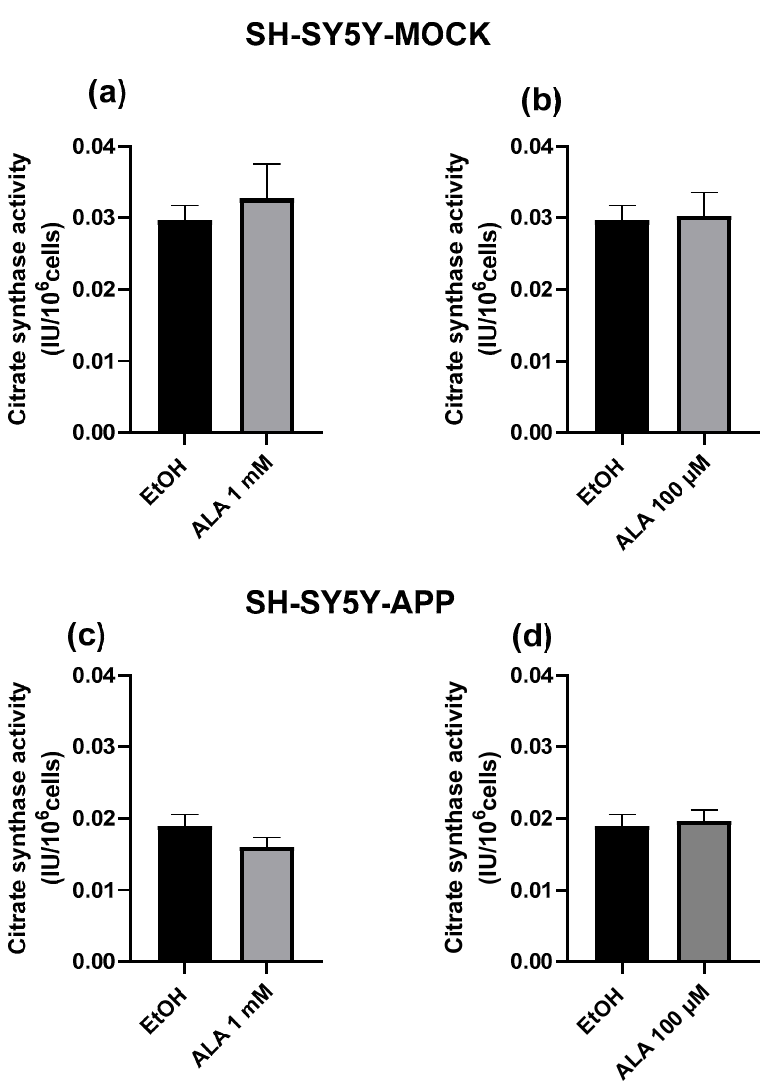
Figure 4. Citrate synthase activity of SH-SY5Y-MOCK cells after 24 h incubation with ( a ) 100 µ M alpha lipoic acid (ALA) or ( b ) 1 mM ALA, ethanol served as a control in both cases. Citrate synthase activity of SH-SY5Y-APP 695 cells after 24 h incubation with ( c ) 100 µ M alpha lipoic acid (ALA) or ( d ) 1 mM ALA, ethanol served as control. Data are displayed as the means ± SEM. N = 10–15. Statistical significance was tested via student’s t -test.